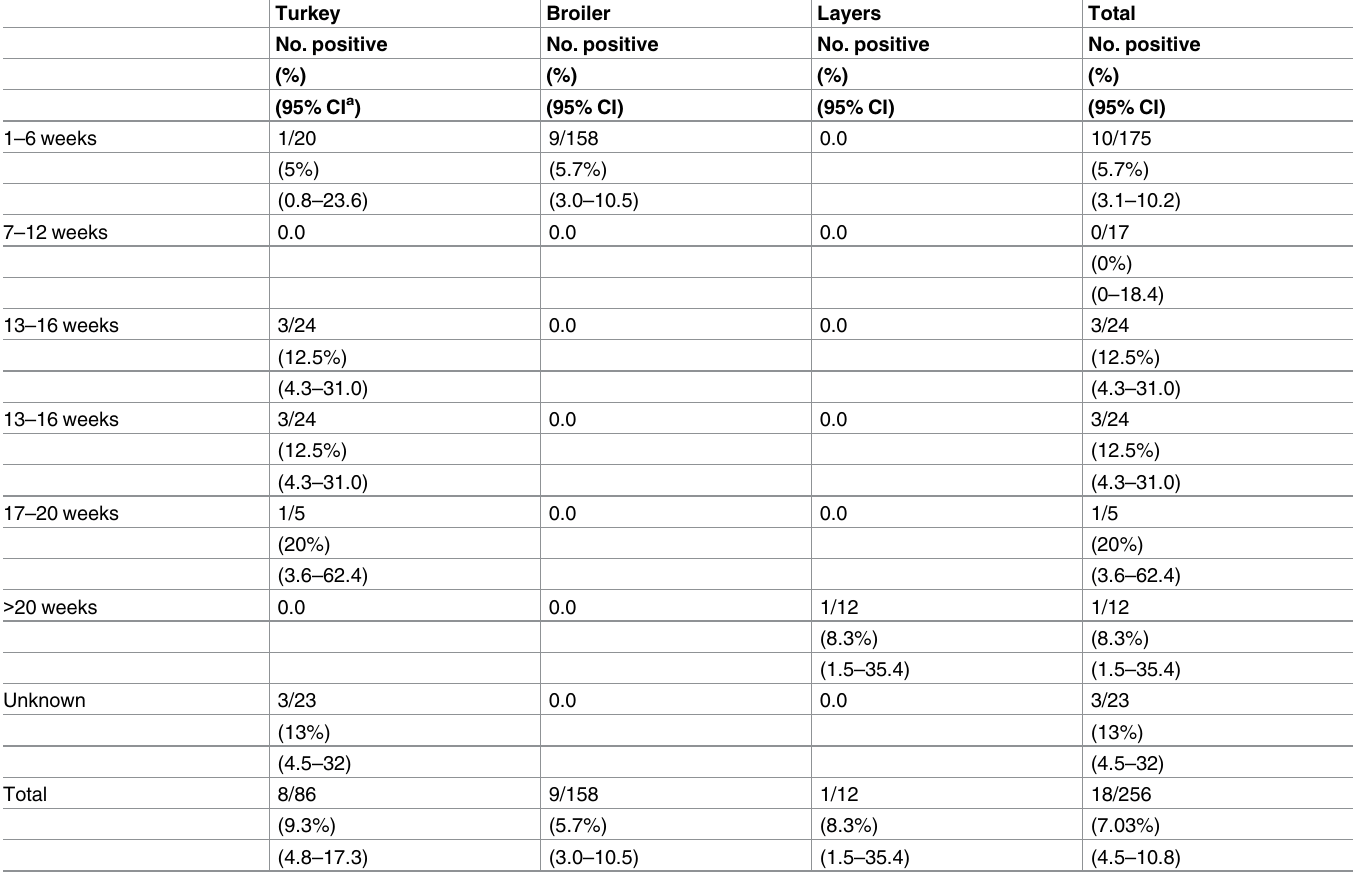
Table 2. Age distribution in relation to detected Cryptosporidium spp. in different poultry